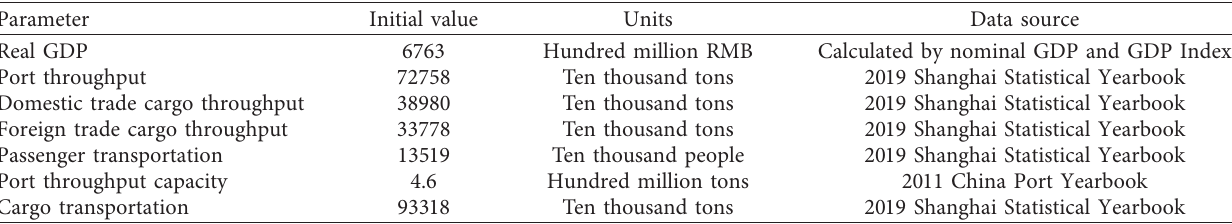
Table 3: Determination of the initial value of the model.